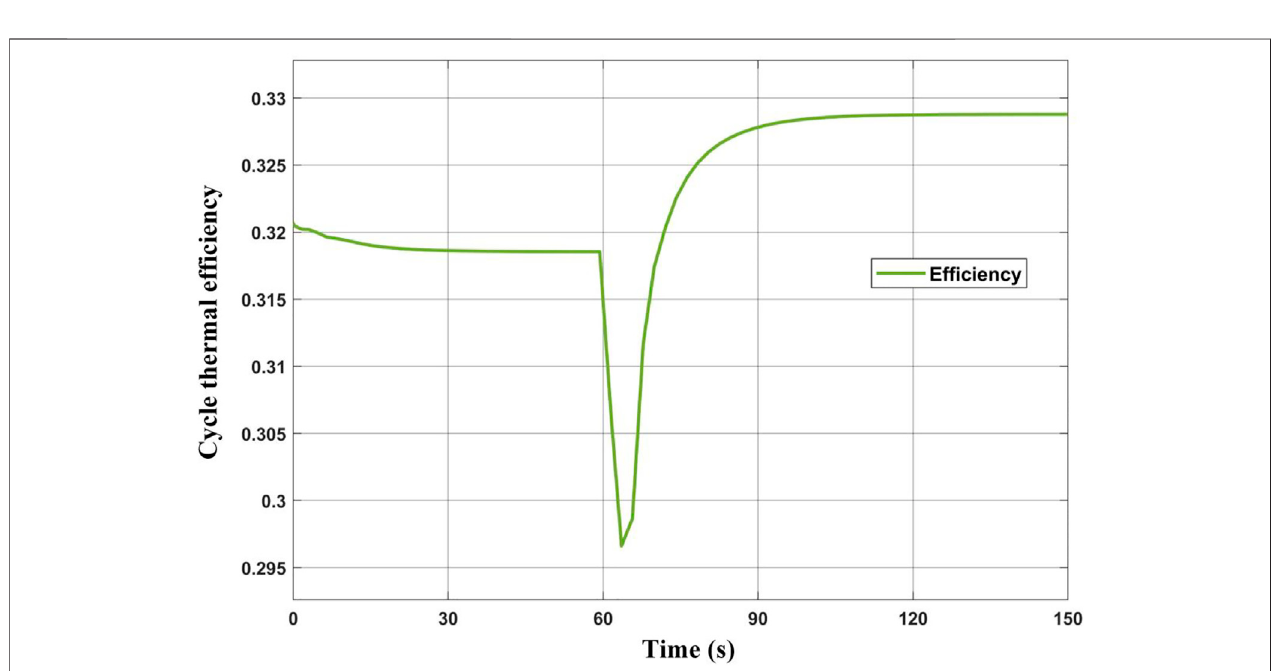
FIGURE 12 | Dynamic response of system thermal ef fi ciency while reducing the cycle mass fl ow rate.